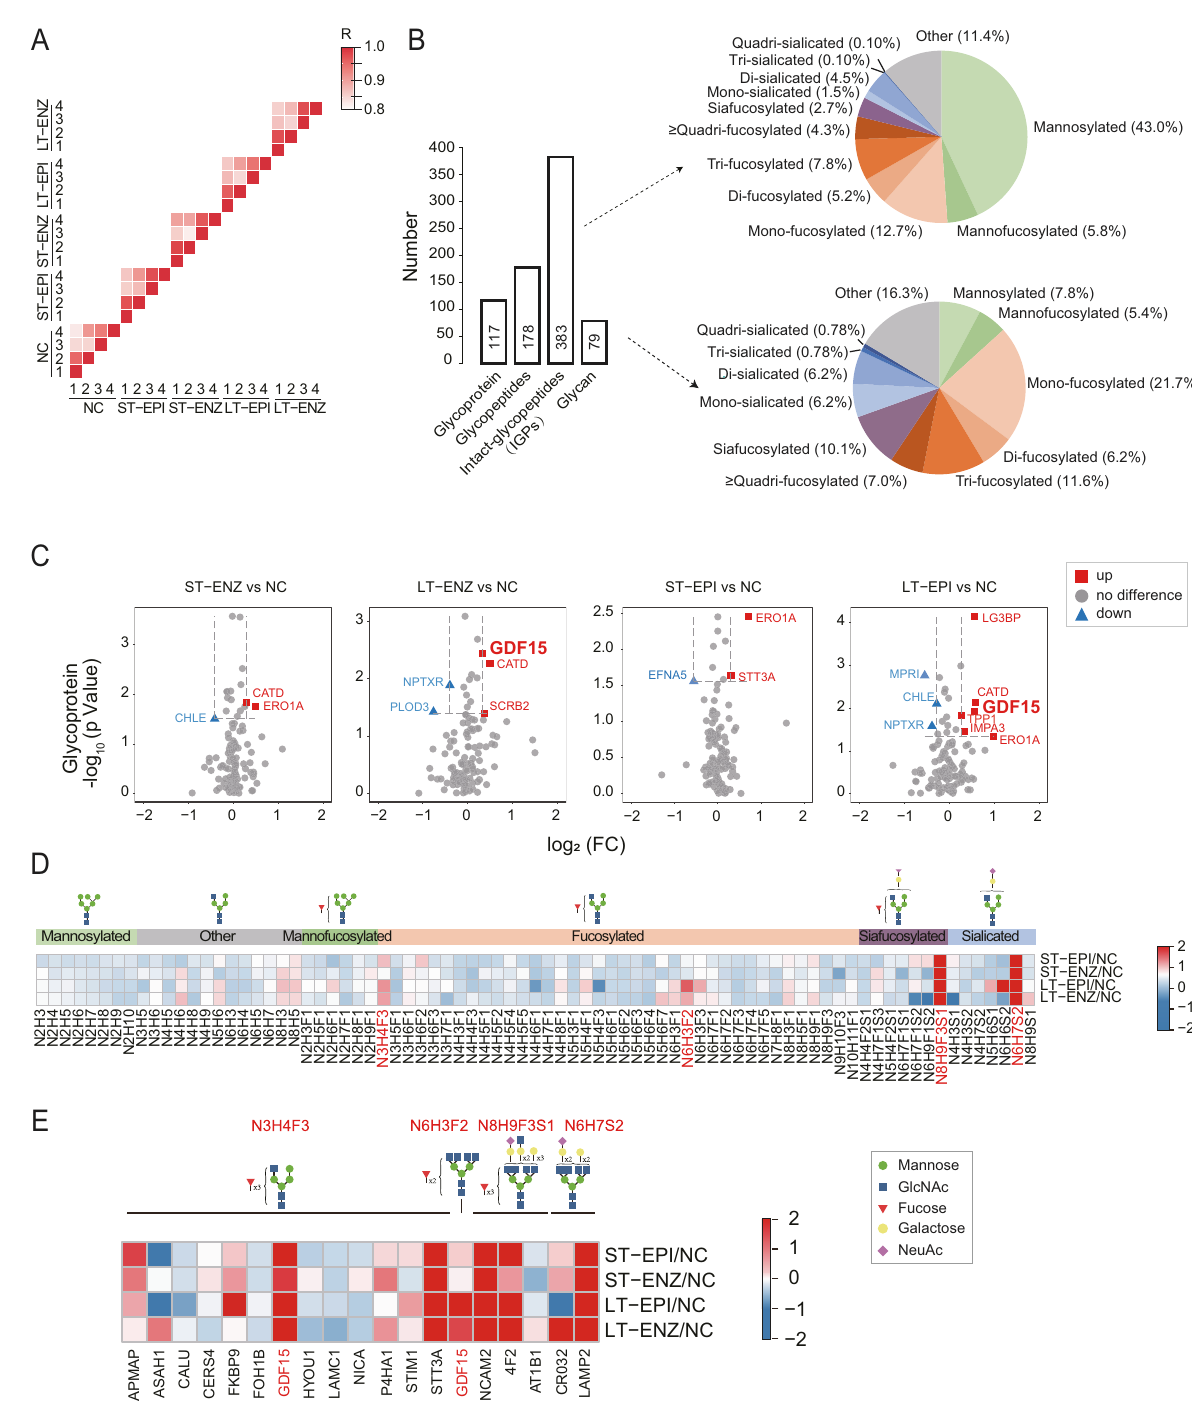
Fig. 2 GDF15 is identi fi ed as a major glycoprotein in IRPC. A Pearson correlation coef fi cient heatmap of quadruplicates indicates reliability of experiment. B Numbers of glycoproteins, glycopeptides, intact N -glycopeptides (IGPs), and glycans identi fi ed are presented. C Volcano plots indicate differentially expressed glycoproteins. p < 0.05. D Heatmap shows differentially expressed glycotypes. E Heatmap displays proteins modi fi ed by up-regulated glycotypes. Red indicates up-regulation, blue indicates down-regulation, and gray indicates no difference. N is HexNAc, H is Hex. F is Fucose. Cartoon symbols used for glycans (see inset) conform to the standard representation recommended by the Consortium for Functional further decreased survival rate (Fig. 6A, B). Inhibition of SRC SRC/AR inhibition signi fi cantly reduces tumor growth in seemed to be more effective than that of EGFR or ERK1. To castrated mice corroborate this observation, we performed rescue experiments Since EGFR pathway is activated in IRPC, we treated LT cells with with the wild-type and kinase dead SRC. We found that EGFR, SRC, ERK inhibitor or siRNA. Pathway interference signi fi - overexpression of the wild-type SCR rescued the inhibition cantly reduced LT cell survival, and together with AR inhibition